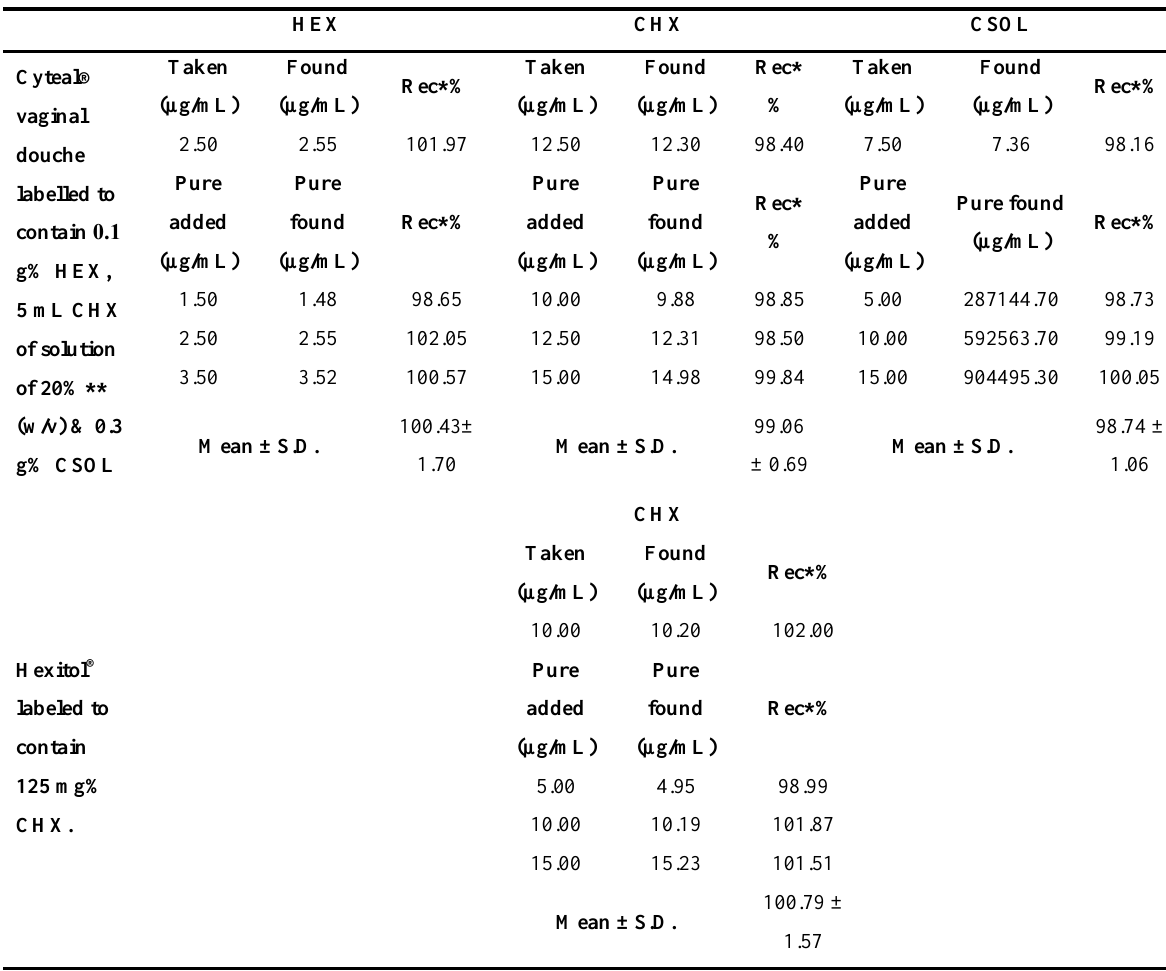
Fig. 9 . HPLC chromatogram of saliva spiked with 2.00 µg/mL CHX at a timed wavelength of 265, 260 & 230 nm. Table 6. Application of the proposed HPLC method by standard addition method for determination of HEX, CHX & CSOL in pharmaceutical